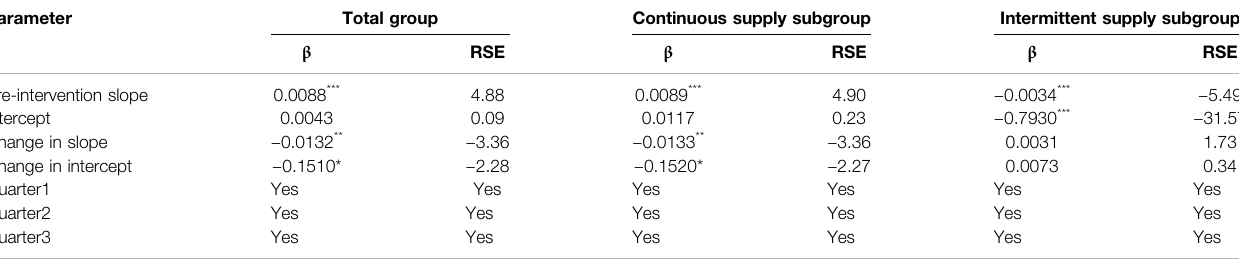
TABLE 3 | Estimated coef fi cients of segmented regression models for the LPCMs supply growth rate before and after the LPMP from 2005 to 2018 ( N (cid:1) 56